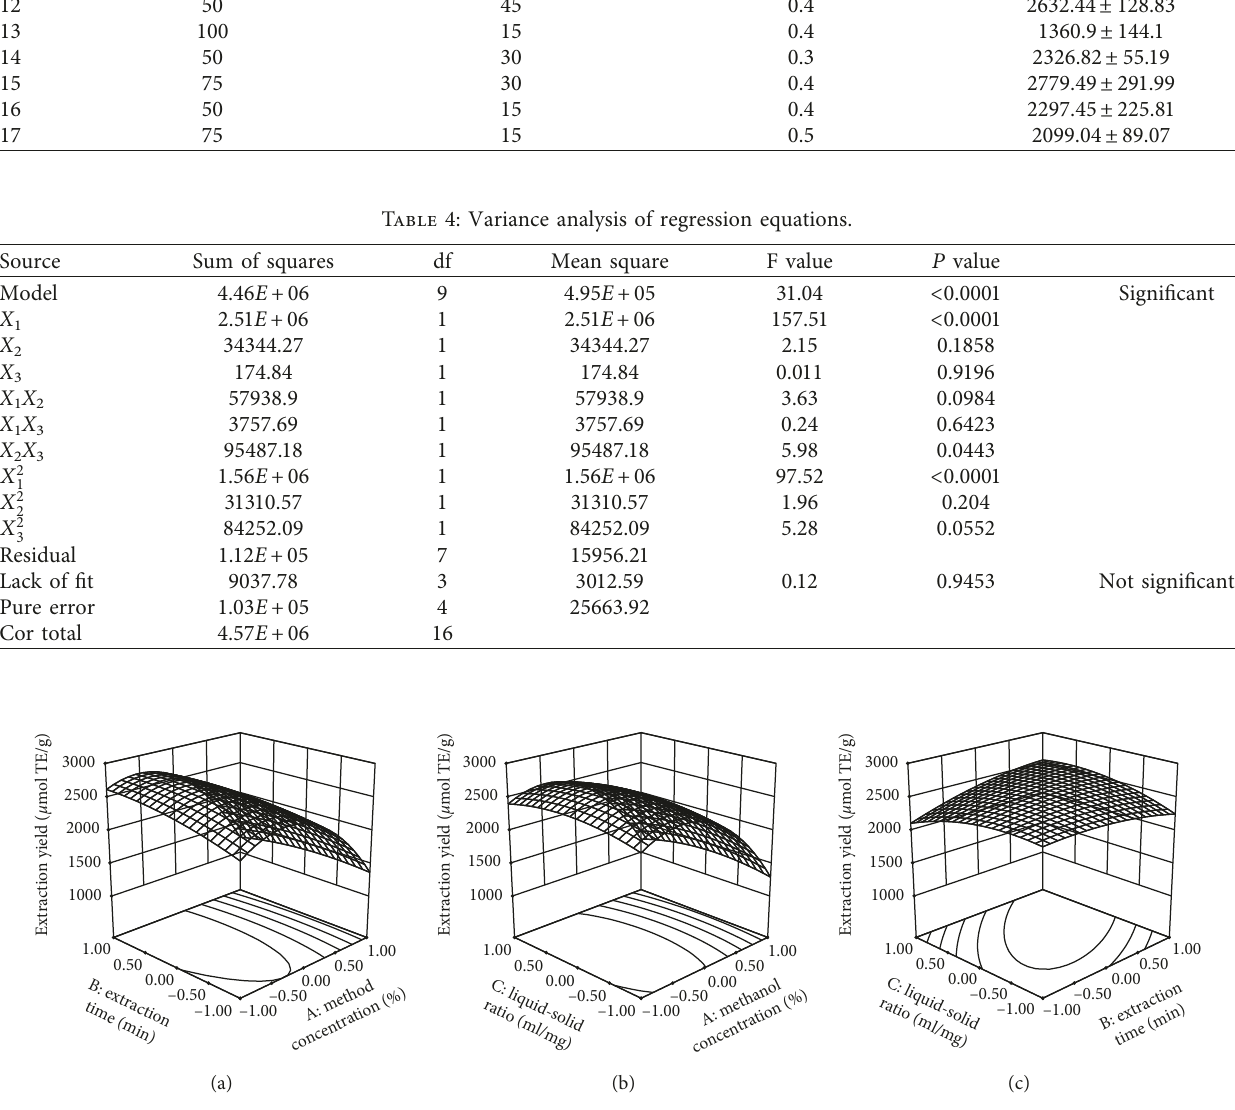
Figure 2: Response surface (3D) showing the influence of different extraction parameters on extraction